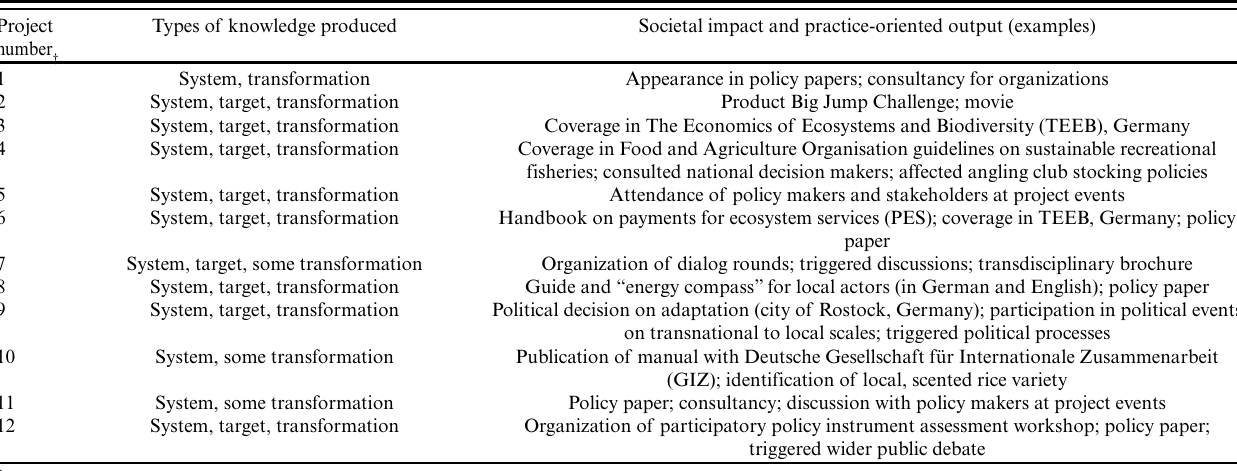
Table 4. Production of different types of knowledge, societal impact, and practice-oriented output of the 12 social-ecological research